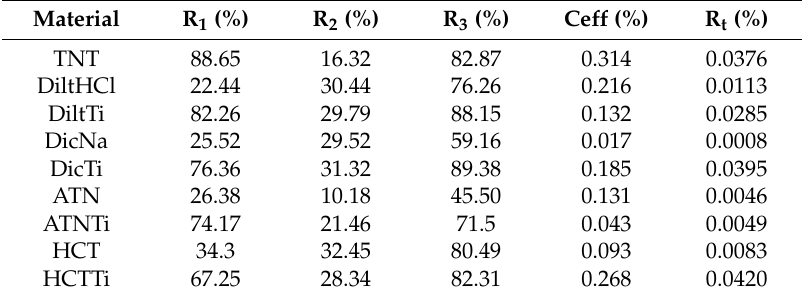
Figure 7. Evolution of net energy (NCW) with TCW of TNT, DicNa and DicTi at 50, 100, 150, 200 and 250 MPa compression pressure. Table 2. Energetic parameters of titanate nanotubes (TNTs), active pharmaceutical ingredients (APIs) and TNT–API composite